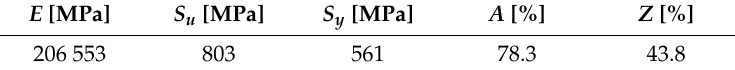
Table 3. Mechanical properties for the 1.4301 steel.